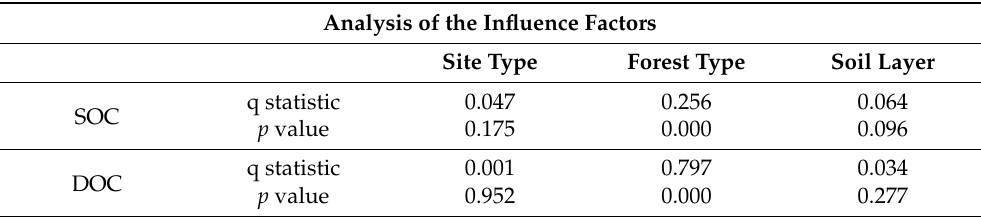
Table 2. Analysis of the influencing factors of the content of SOC and DOC.